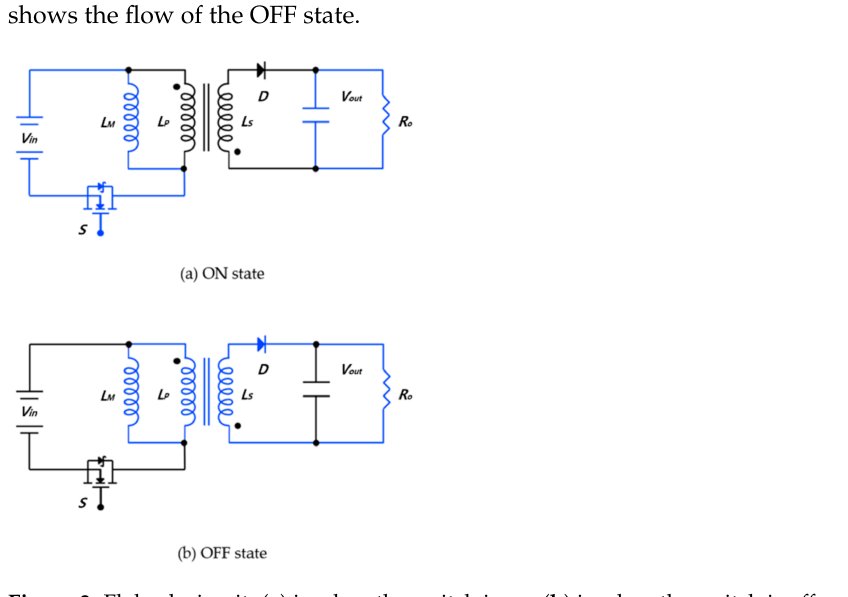
Figure 3. Flyback circuit. ( a ) is when the switch is on. ( b ) is when the switch is